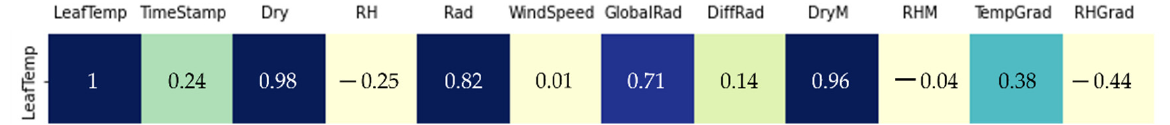
Figure 5. Leaf temperature and errors in estimation: ( a ) comparison between measured and pre- dicted temperature; and ( b ) each model error as a function of the measured value.